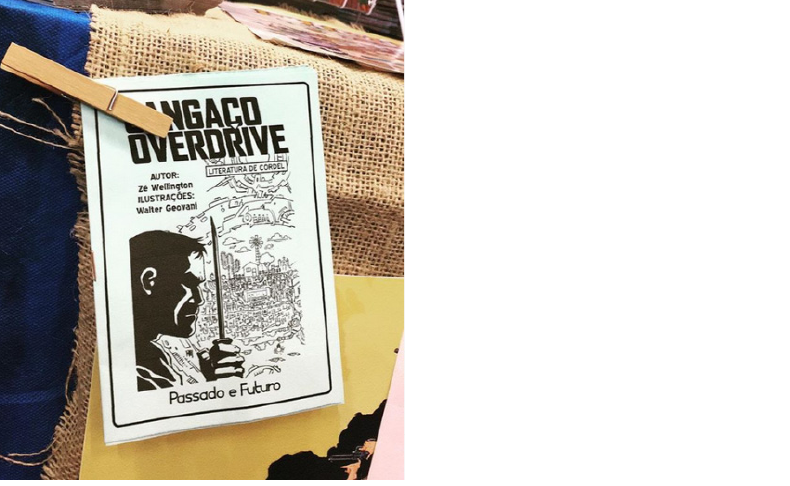
Figure 3. Image taken from Zé Wellington’s website (the comic exhibited at the CCEX in the traditional manner hanging with a clothes pin).